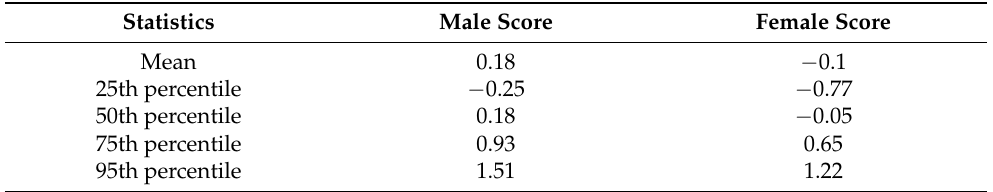
Table 4. Descriptive statistics of the standardized e-commerce awareness and loyalty level score.